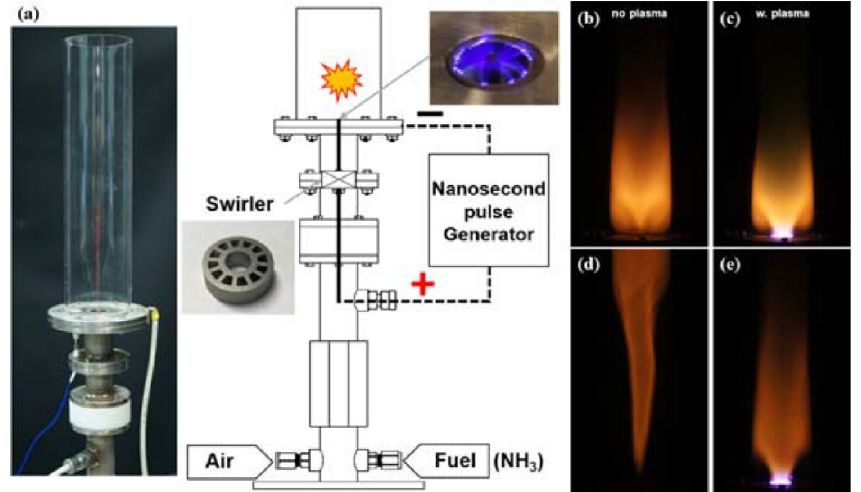
Figure 16. Experimental apparatus and direct photographs of flame with and without plasma: (a) Combustor; ( b ) and ( c ) are at φ = 0.94, ( d ) and ( e ) are at φ = 0.71. Courtesy of Elsevier [90].